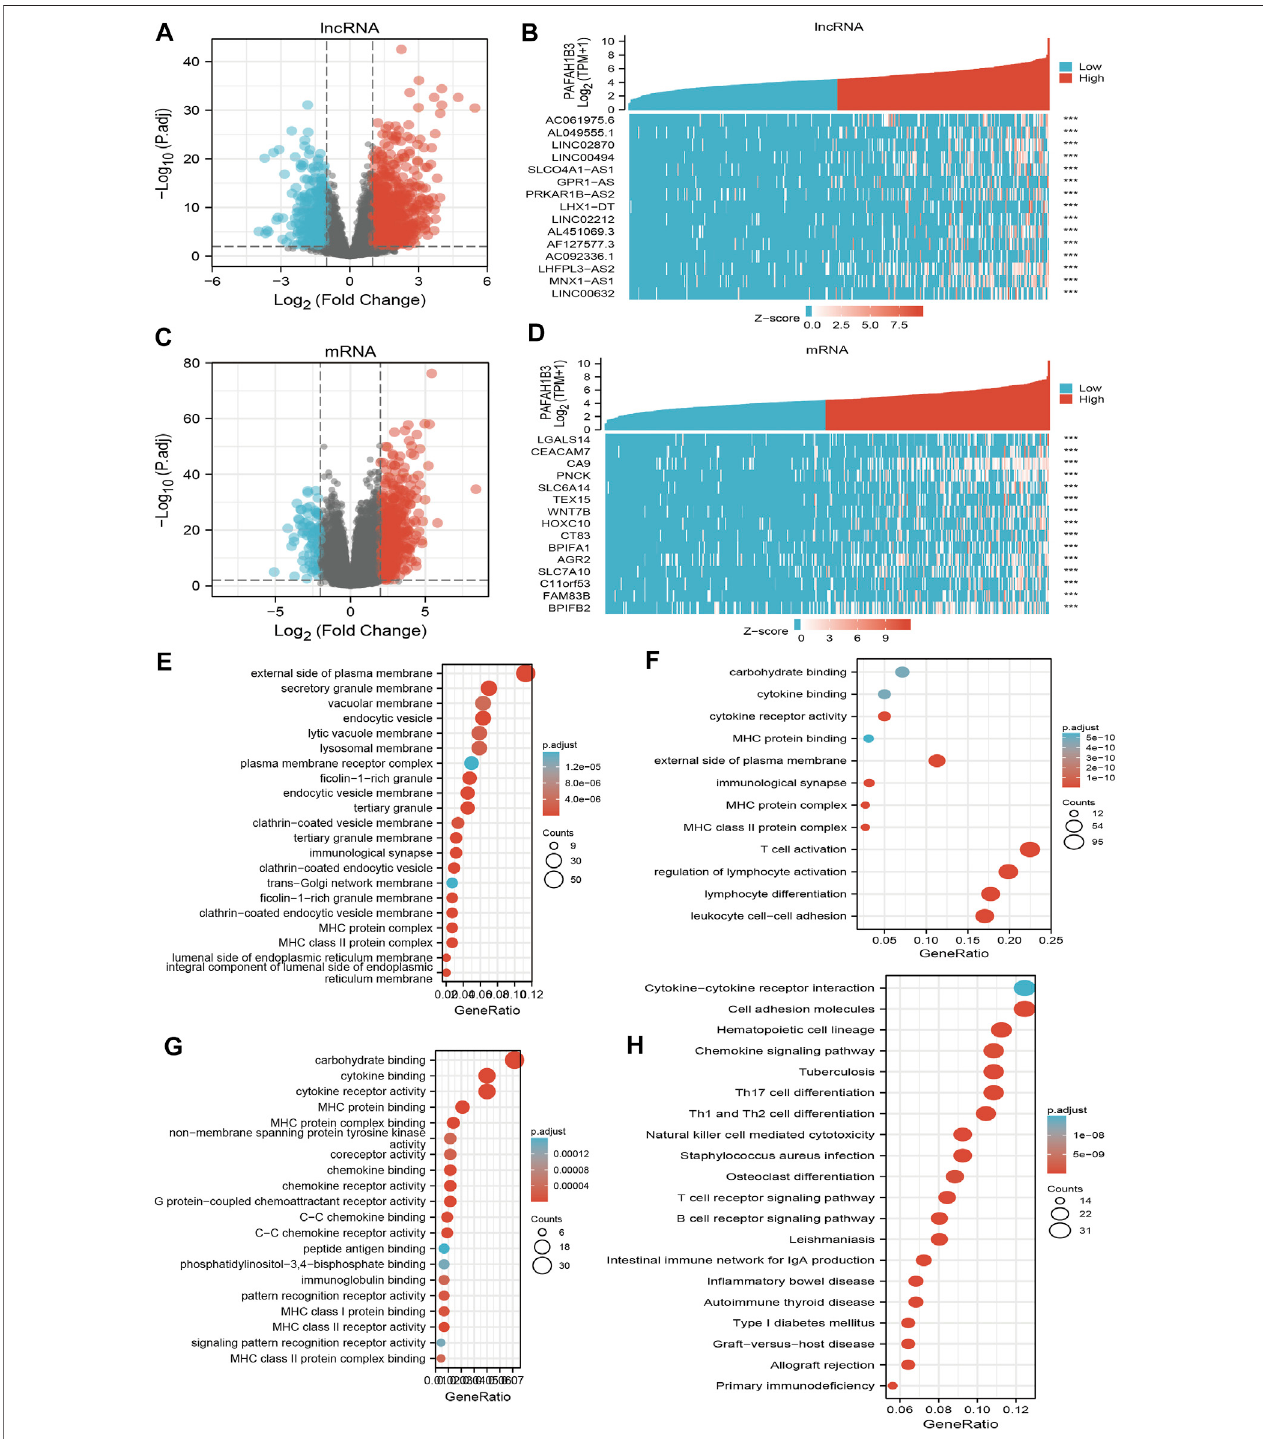
FIGURE 10 | Identifying differentially expressed genes between high and low expression of PAFAH1B3 groups. (A) Volcano plot of differential lncRNA pro fi les between PAFAH1B3 high expression and PAFAH1B3 low expression. (B) Hot map of the top 15 DEGs (lncRNA) between PAFAH1B3 high expression and PAFAH1B3 low expression. (C) Volcano plot of differential mRNA pro fi les between PAFAH1B3 high expression and PAFAH1B3 low expression. (D) Hot map of the top 15 DEGs (mRNA) between PAFAH1B3 high expression and PAFAH1B3low expression. (E – G) The GO term of PAFAH1B3analysis byusing differentially expressed genes. (H) The KEGG term of PAFAH1B3 analysis by using differentially expressed genes.